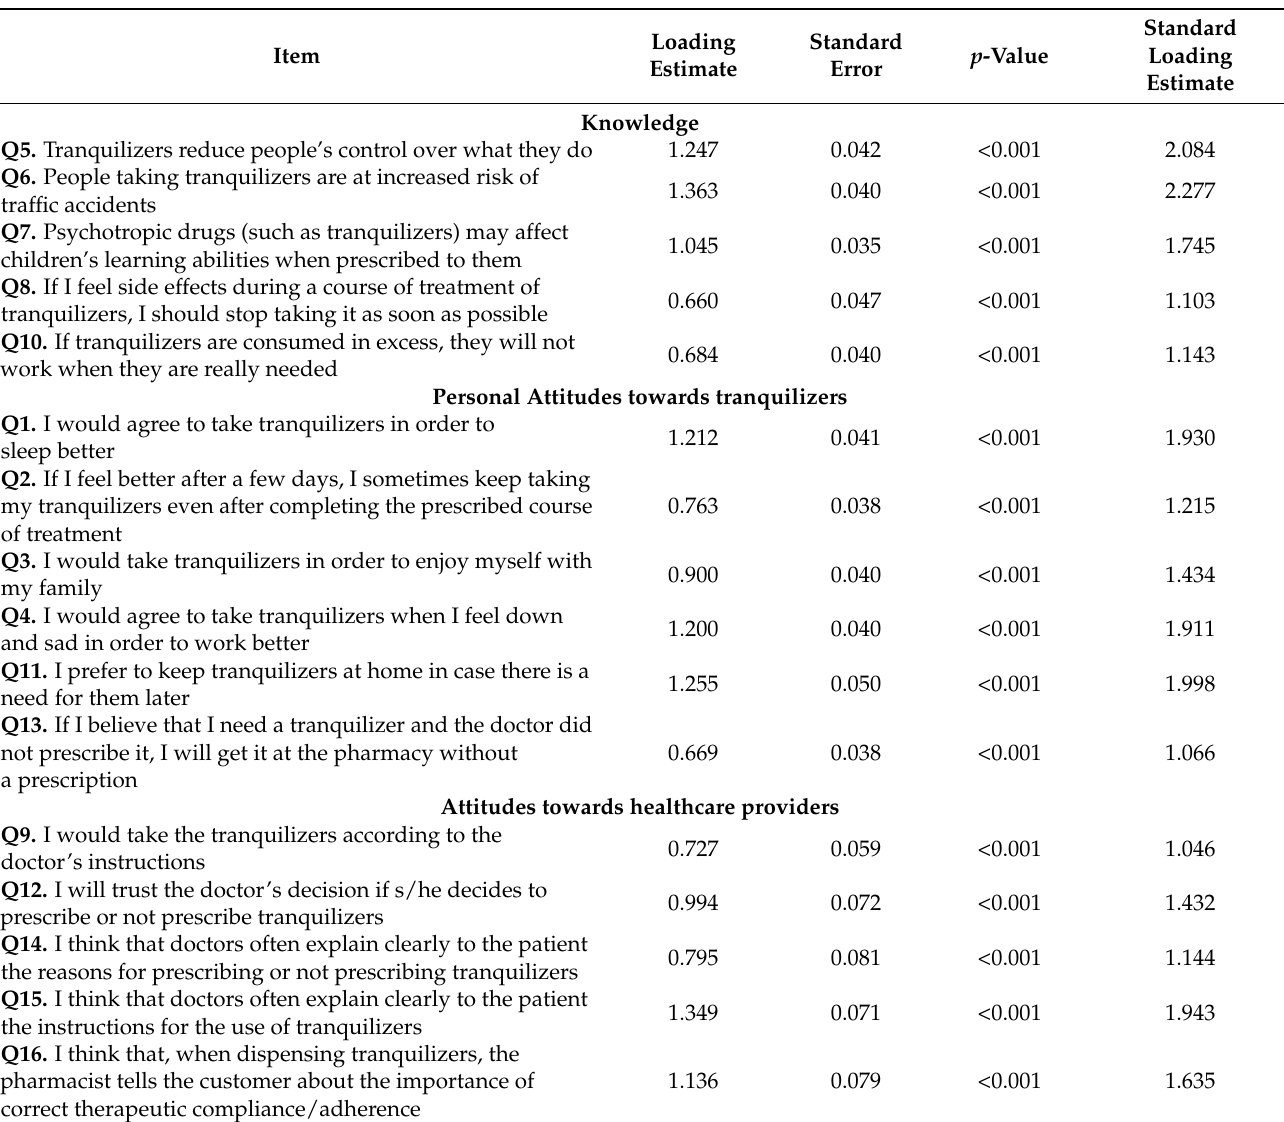
Table 3. Factor loadings and standard errors from the three-factor model of the KAP questionnaire on tranquilizer